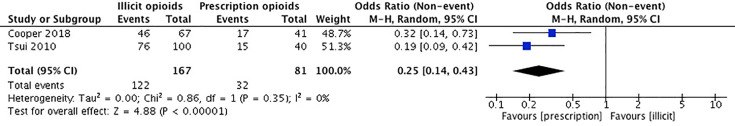
Forest Plot for Any Injection Drug Use.